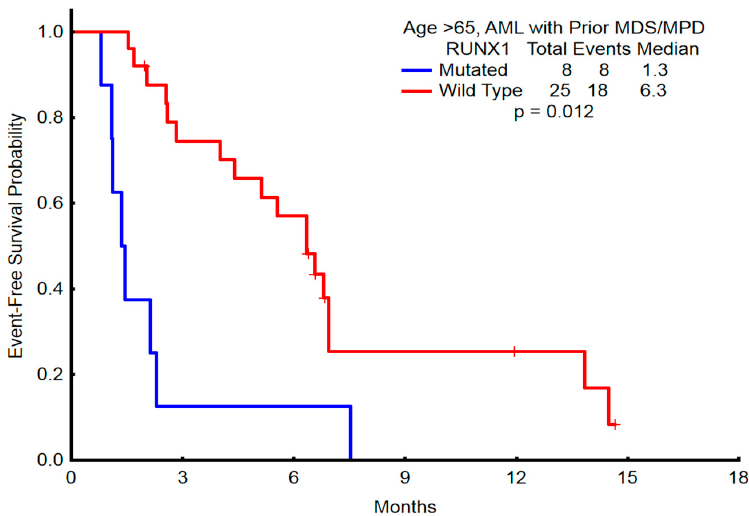
Figure 5. Event-free survival in patients with prior MDS/MPN who were older than 65 years and received HMA induction therapy.